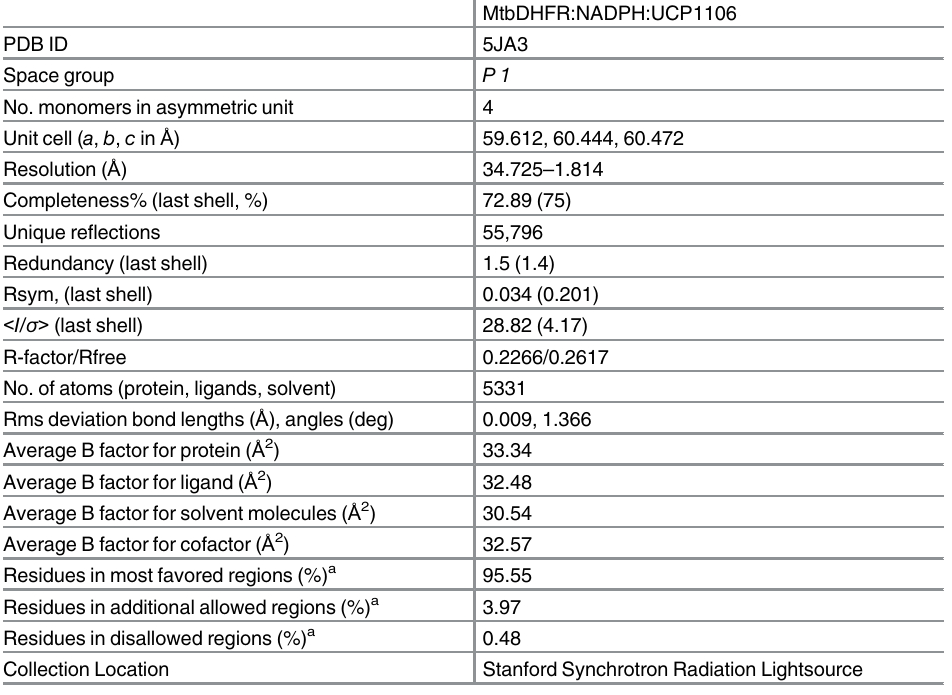
Table 3. Data collection and Refinement